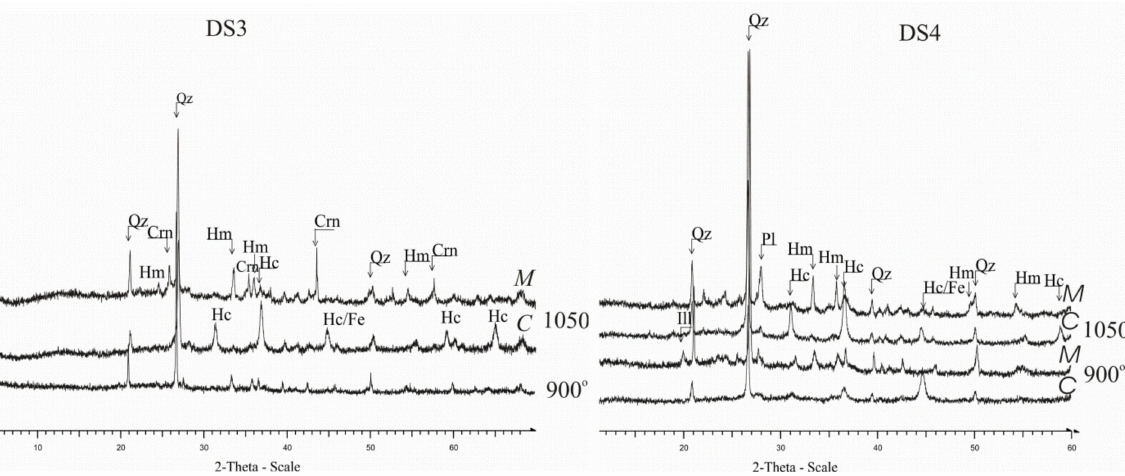
Figure 16. Composite graphs of the X-ray patterns from the fired non-calcareous material (700–1050 ◦ C). Abbreviations: Qz = quartz, Cc = calcite, Pl = plagioclase, Ill = illite, Hm= hematite, Hc = hercynite, Fe= metal iron, Crn = corundum, M = margin, C =